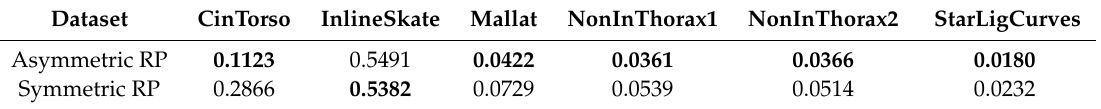
Table 4. Comparison in terms of error rates between symmetric RP and asymmetric RP.